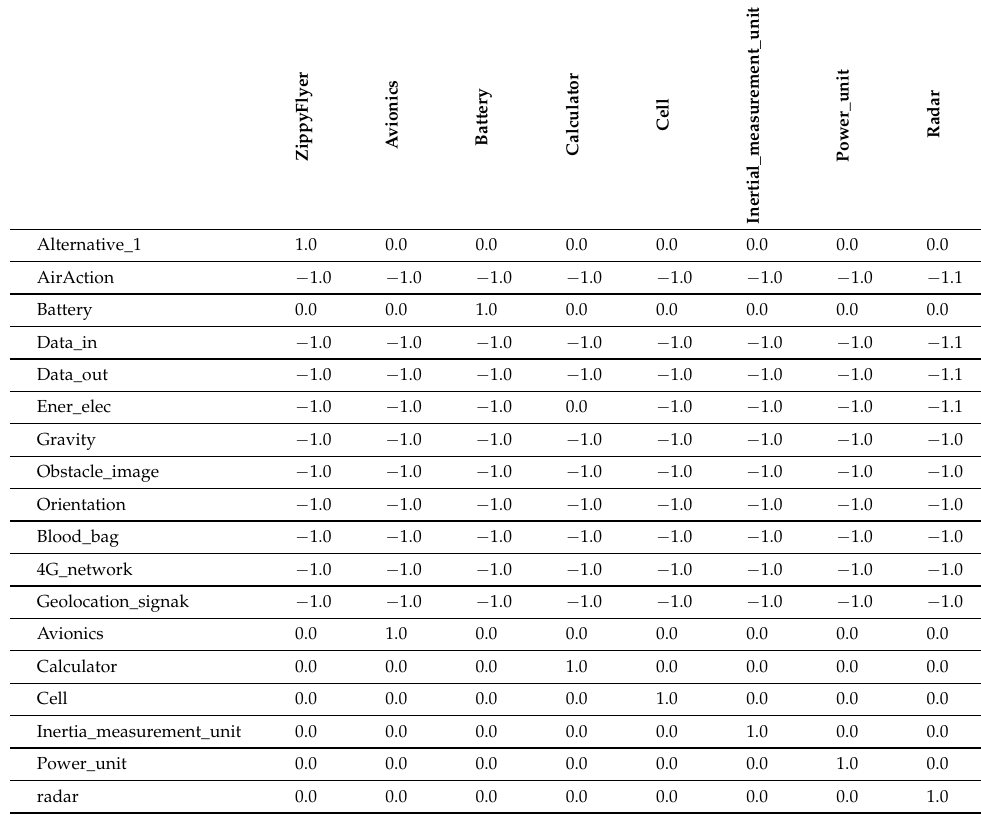
Table 1. Correspondence table for the first iteration of the comparison between the SysML and AltaRica 3.0